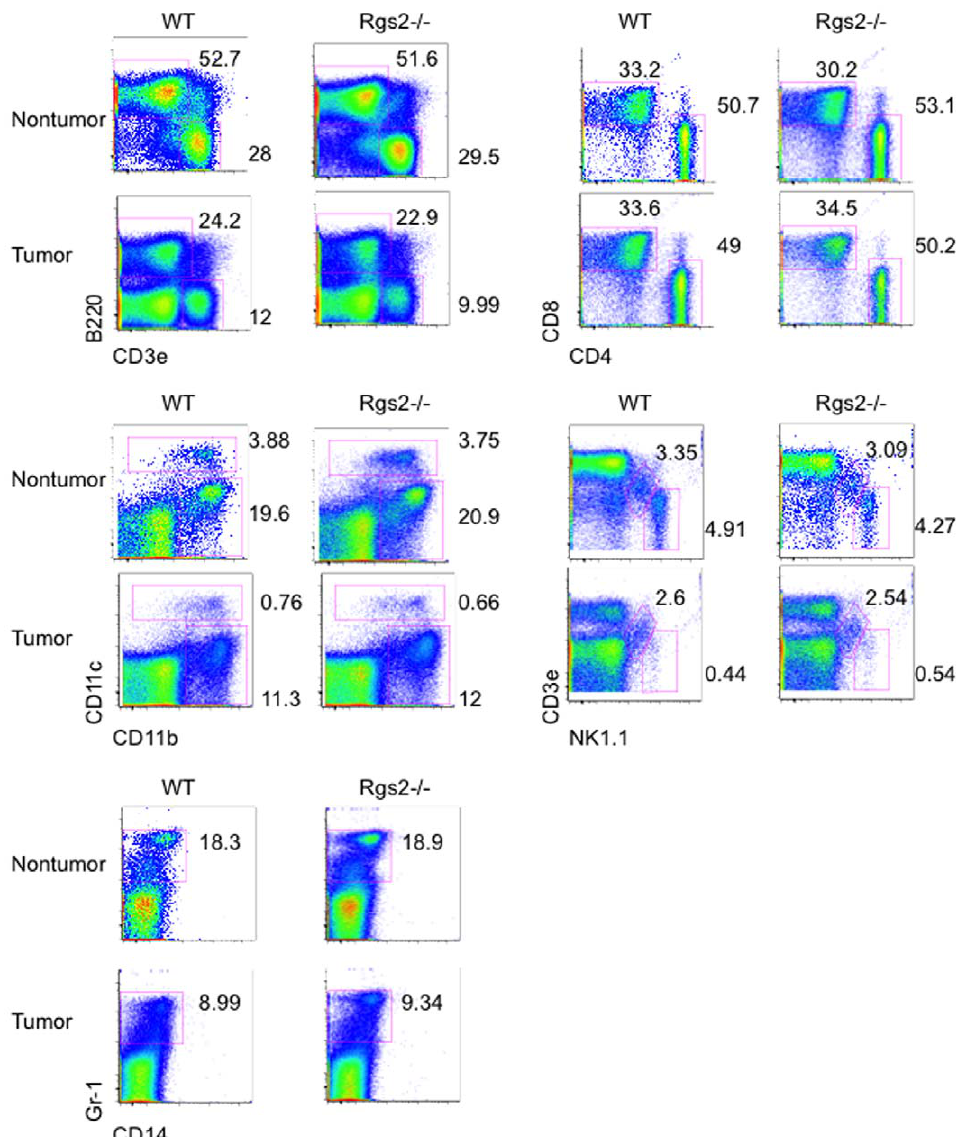
Figure 4. Lack of Rgs2 does not affect populations of mature leukocytes. Spleens were isolated from non-tumor bearing and 3LL tumor bearing WT and Rgs2 2 / 2 mice, processed into single cell suspensions, and labeled with the indicated antibodies, then analyzed by flow cytometry. Experiment was performed 3 times with 3–4 mice per group.